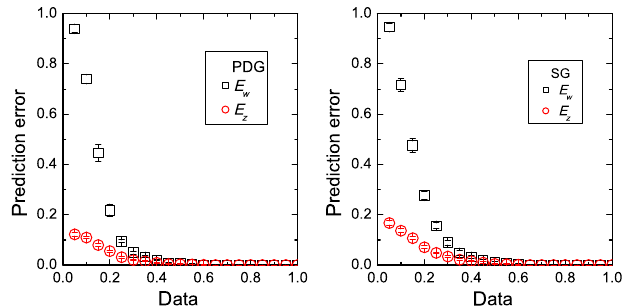
FIG. 3. Prediction errors E w in link weights and E z in non- existent links for PDG on weighted scale-free networks. The network size is 100, and the weights follow a uniform distribu- tion, ranging from 1.0 to 6.0. Each value of the prediction error is obtained using 10 independent network realizations. Other pa- rameters are the same as for Fig. 1.